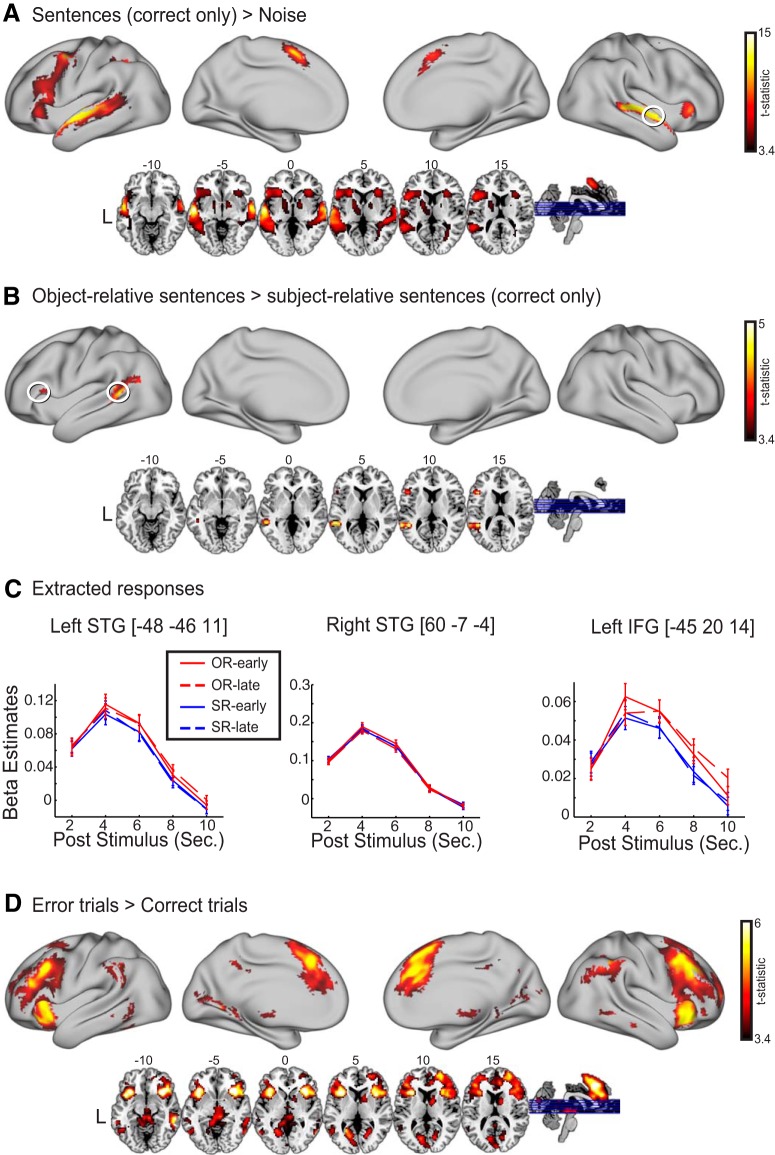
A, Increased activity for sentences > noise, limited to sentences with a correct behavioral response. B, Increased activity for object-relative sentences compared to subject-relative sentences, limited to sentences with a correct behavioral response (p < 0.053). C, Time course of hemodynamic response from three peak voxels (indicated with white circles). The error bars indicate standard errors. D, Increased activity for trials with errors compared to correct trials.